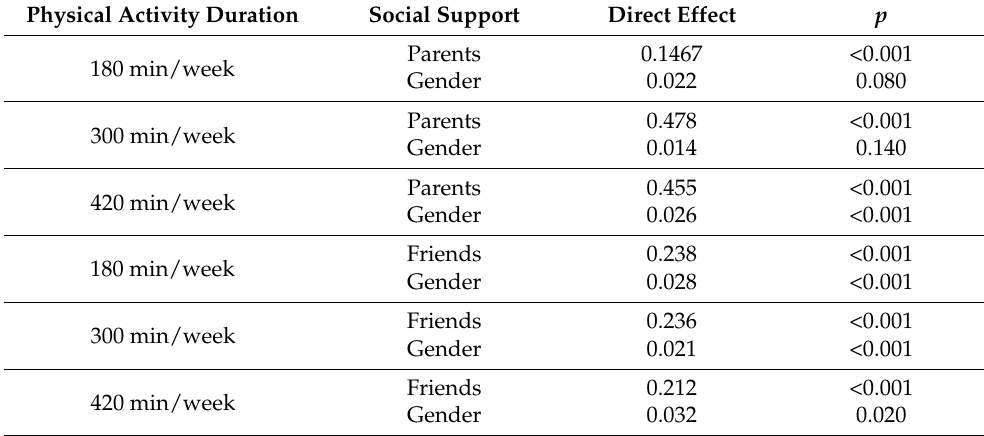
Table 3. Association of social support from parents and friends with the moderate-to-vigorous physical activity of adolescents ( N =